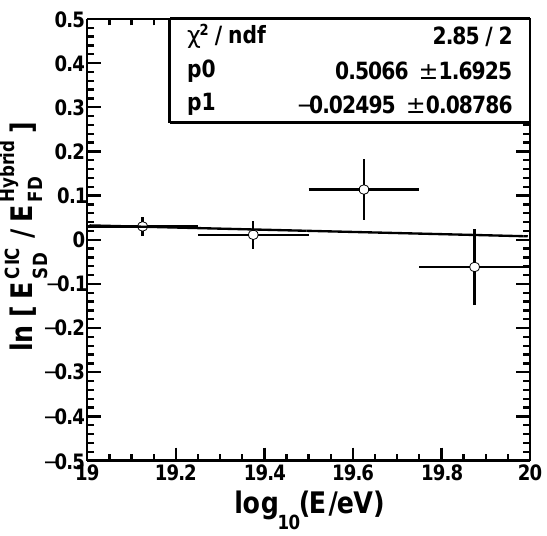
Figure 8. Natural log of the ratio of the TA SD energy esti- mated using the CIC method to the TA FD energy, plotted versus energy. A fit to a straight line gives a slope of -0.02, which is within its fitting uncertainty of 0.09, indicating that there is no non-linearity of the SD CIC energy with respect to the